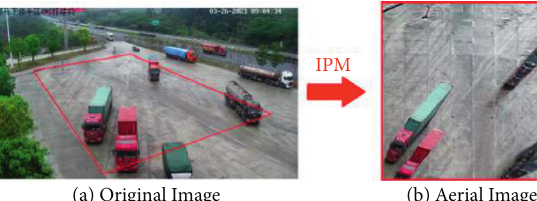
Figure 4: IPM transformation of the surveillance image. (a) Original image. (b) Aerial